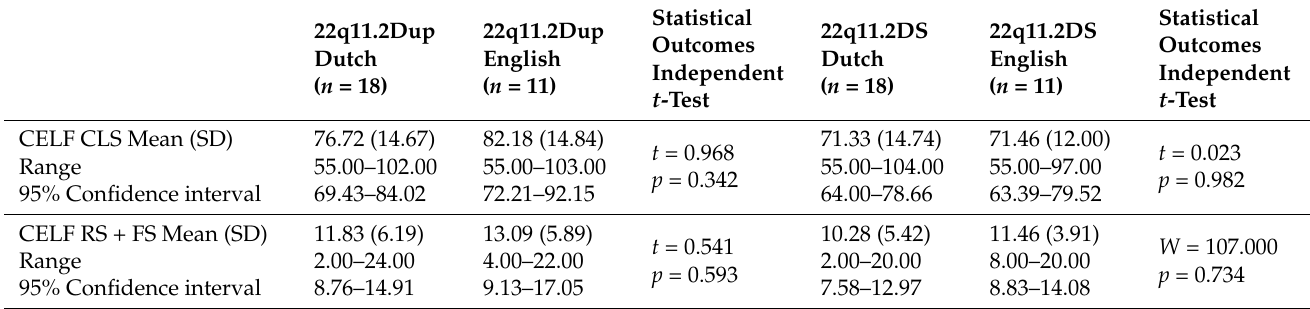
Table 2. Mean composite results on CELF across CNV groups and cohort sites.